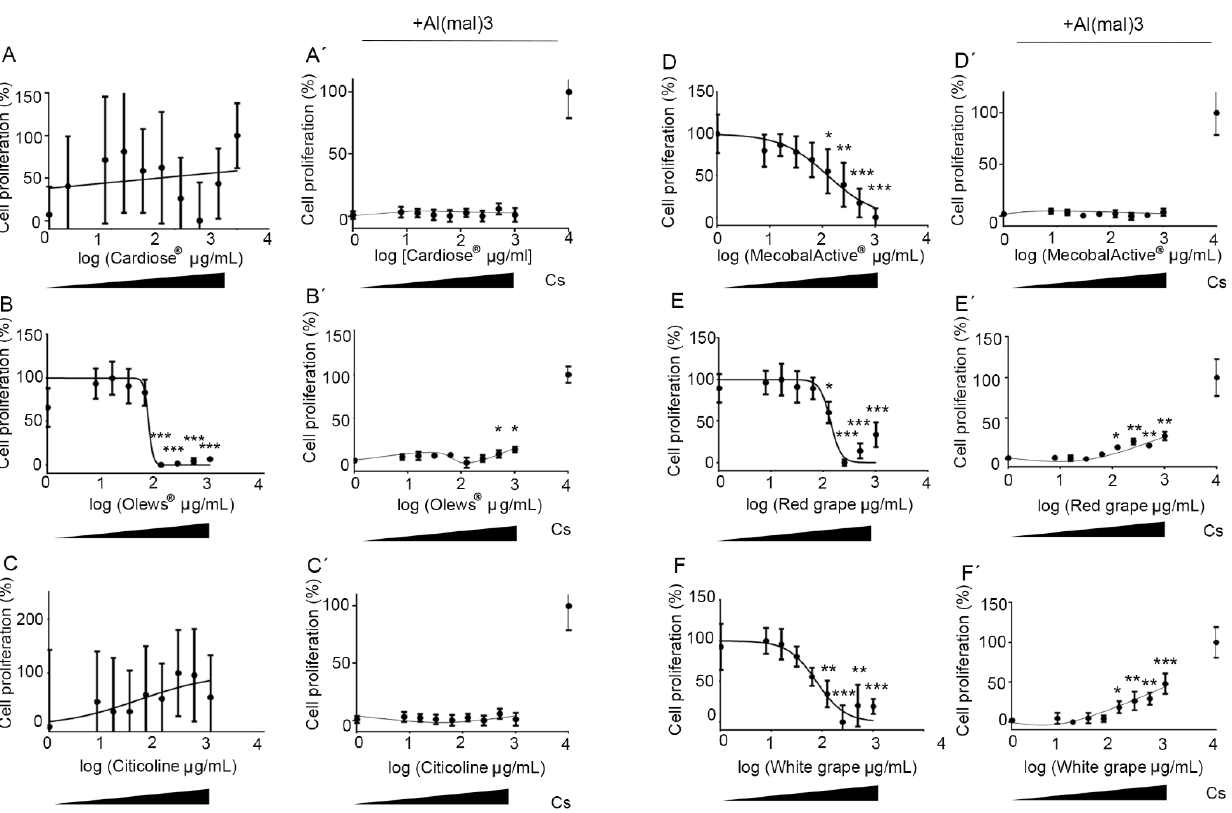
Figure 1. Neuroprotective effects of the extracts on the SH-SY 5Y cell line. Dose-response curve effects of the extracts on the SH-SY 5Y cell line. Cells were incubated with different concentrations of Cardiose ® ( A ), Olews ® ( B ), citicoline ( C ), MecobalActive ® ( D ), red grape ( E ), or white grape extracts ( F ) for 72 h in the absence ( A – F ) or presence ( A ′– F ′) of 125-µM Al(mal) 3 . Data are normalized and expressed as a percentage of the over-basal response (mean ± SEM). Significant differences were analyzed on data from eight different experiments; one-way ANOVA and Dunnett’s multiple comparison post-hoc test were used for statistical analysis. ∗ p < 0.05, ∗∗ p < 0.01, and ∗∗∗ p < 0.001 versus cells or Al(mal) 3 treatment. Cs: control cells, not exposed to Al(mal) 3 .